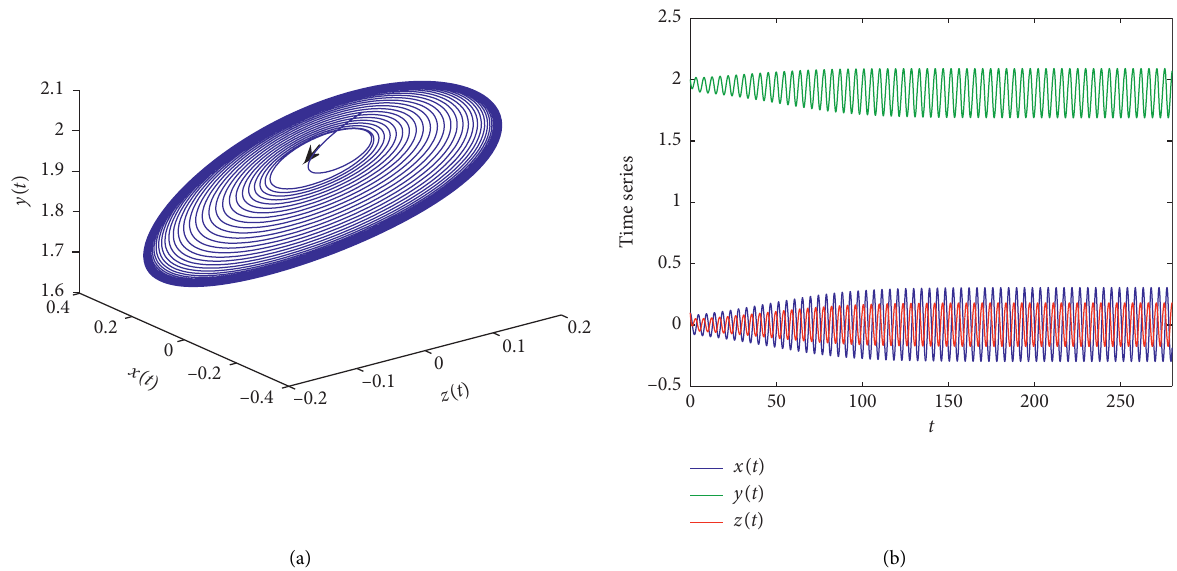
� 1 . 5 > τ 0 and 1 1